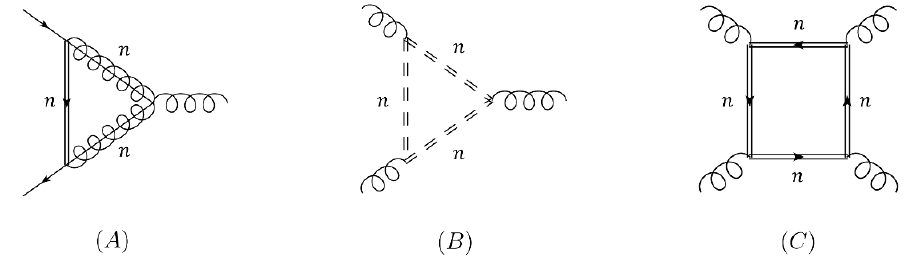
Figure 3 . Sample diagrams for the KK-contributions to the SM vertices. (A) Three-point gluon Vertex (B) Quark-gluon Vertex (C) Four-point gluon vertex. Similar to (cid:12)gure 1, a spring-straight line, solid double line and broken double line indicate the propagator of a level-n KK gluon, KK quark, and Goldstone mode of a KK gluon,